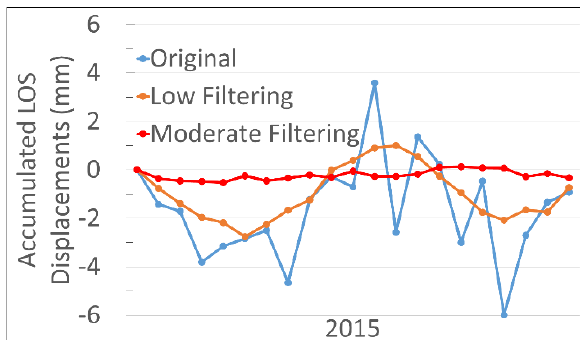
Figure 8. Time-series displacements of stable point (Figure 7). Blue, original; Orange, low filtering; Red, moderate filtering.